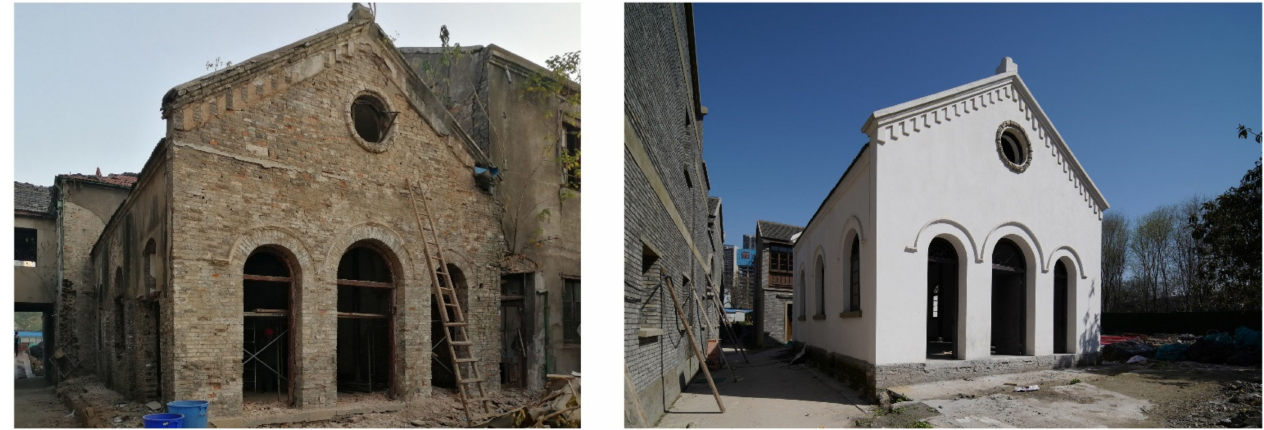
Figure 25. Xiaguan Catholic Church before conservation ( left ) and after conservation ( right ). Through conservation and restoration, the historical features of the “Tianzihao” colony